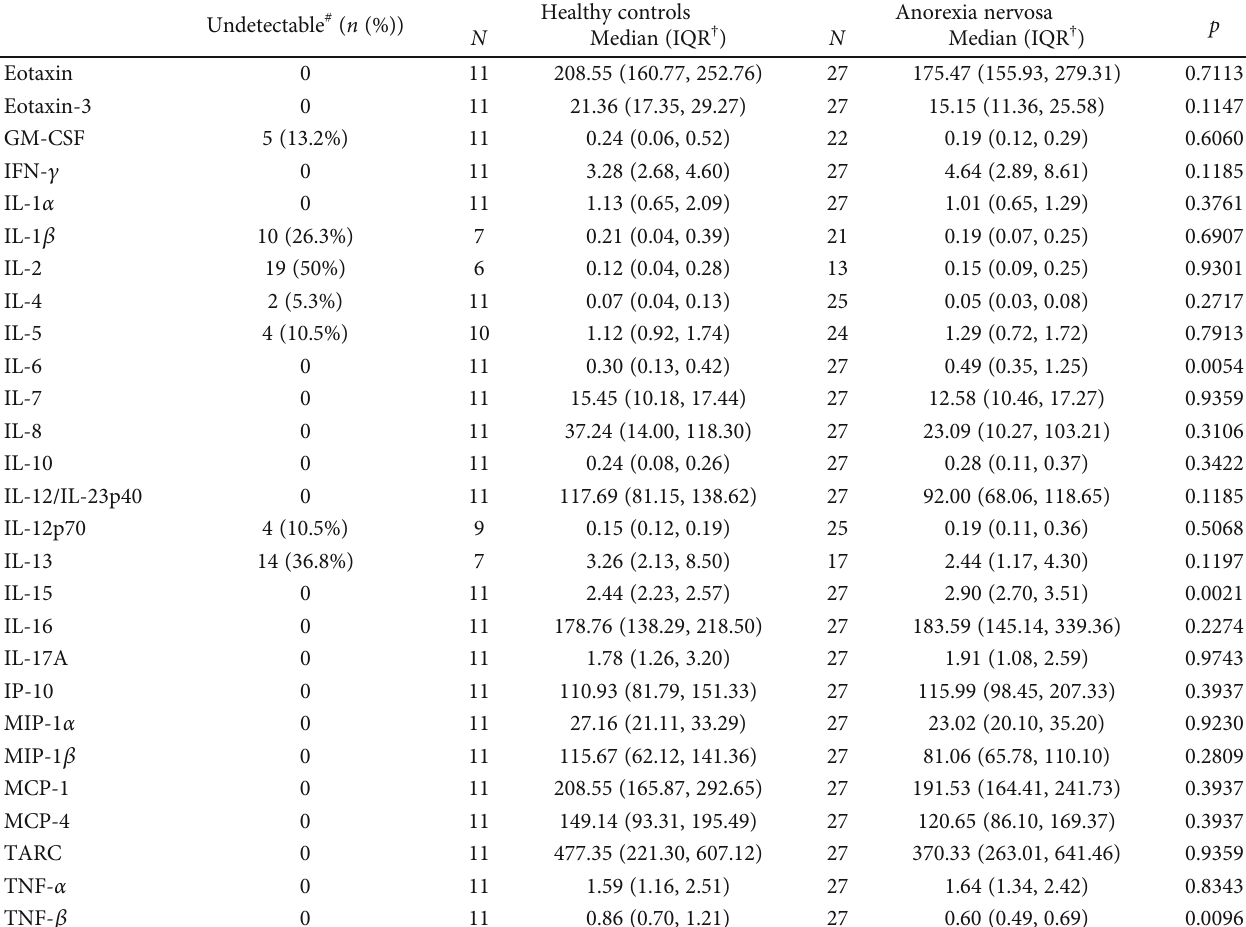
Table 2: Number of participants with undetectable cytokines for each cytokine in the whole sample ( n = 38 ) with median serum concentrations (pg/ml, with interquartile range) of cytokines for HC ( n = 11 ) and AN ( n = 27 ) participants, with a signi fi cance value of group